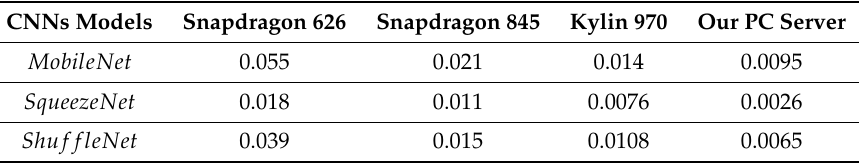
Table 7. Execution time on Android devices